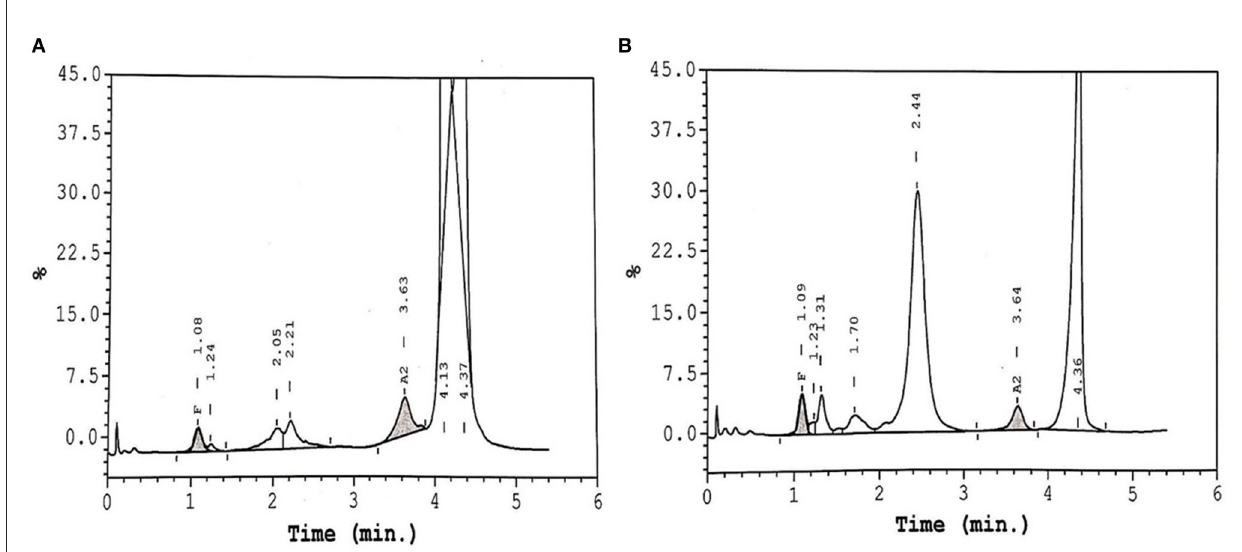
FIGURE1 HPLC chromatogram of two patients on Voxelotor therapy. (A) Shows the presence of HbS and Hb-Voxelotor fraction in the HbD window. (B) Shows a SCD patient on Voxelotor therapy showing only HbS without any HbD